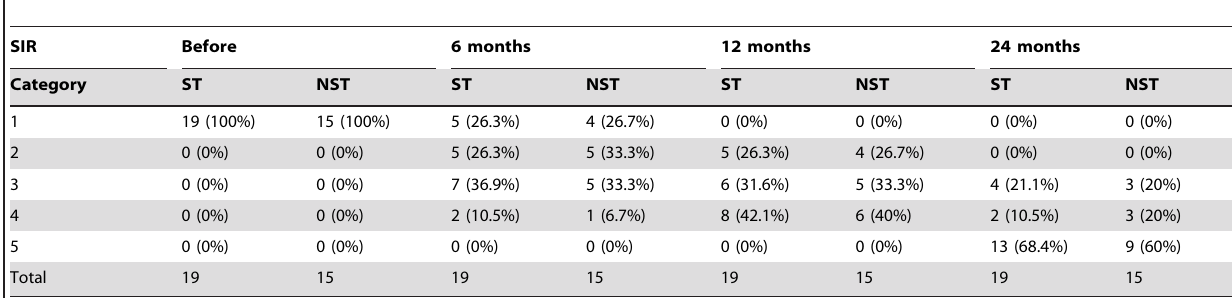
Table 2. Numbers of patients in each SIR category before implantation, 6, 12, 24 months after implantation.